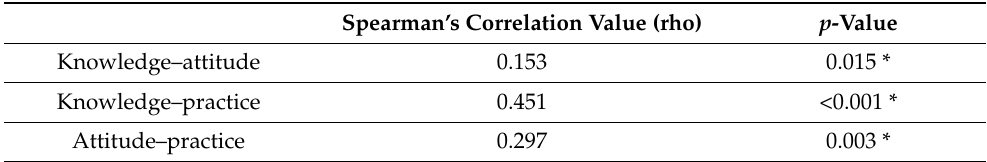
Table 3. Correlation between knowledge, attitude, and practice